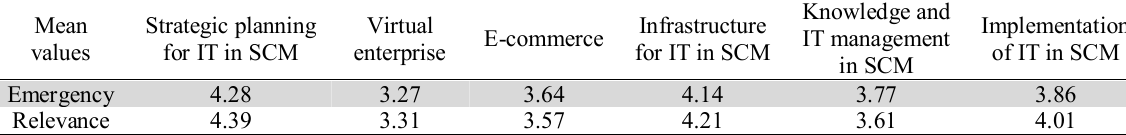
The mean values of the final component based on relevance and